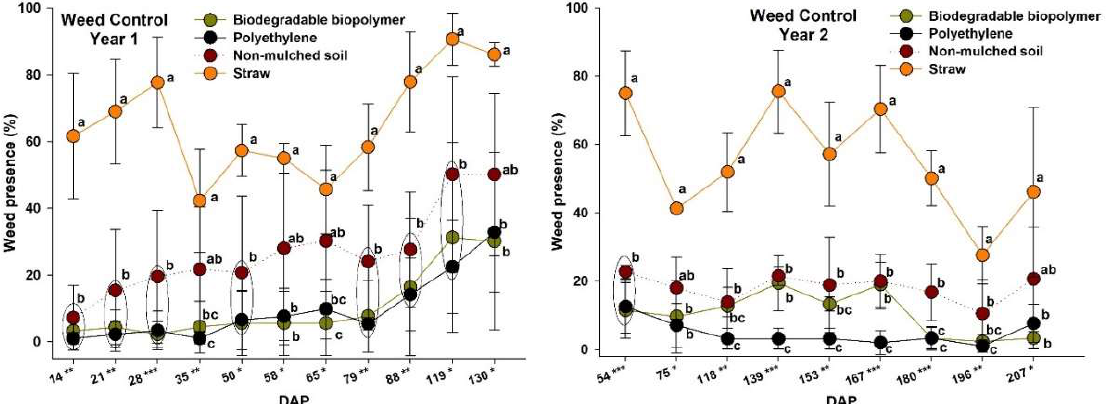
Figure 6. Weed presence during the two crop seasons depending on mulch type and for non-mulched soil. Values (mean ± standard deviation; n = 3). Different letters in the same week indicate significant differences ( p ≤ 0.05, Fisher´s LSD test). ‘*’, ‘**’, and ‘***’ indicate significance at p ≤ 0.05, 0.01, and 0.001, respectively. DAP: Days After Planting.